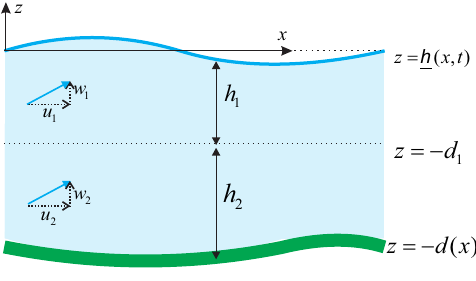
Figure 1. Sketch of two layer